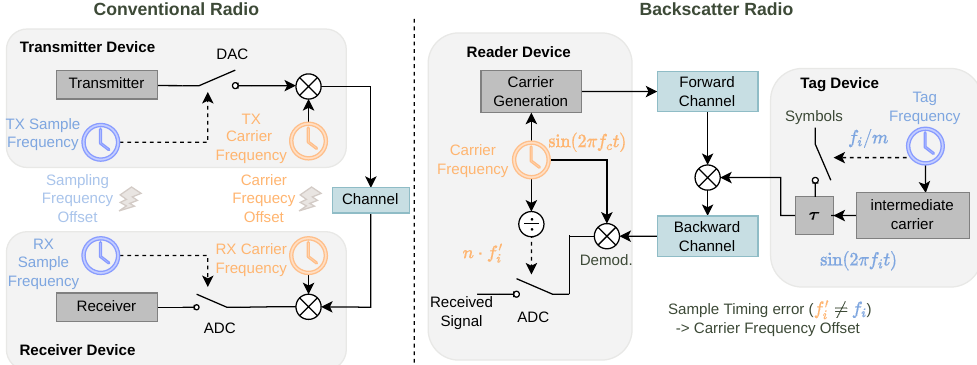
Figure 7. In the backscatter radio, the CFO and Symbol Timing Error (STE) stem from a mismatch in the same pair of